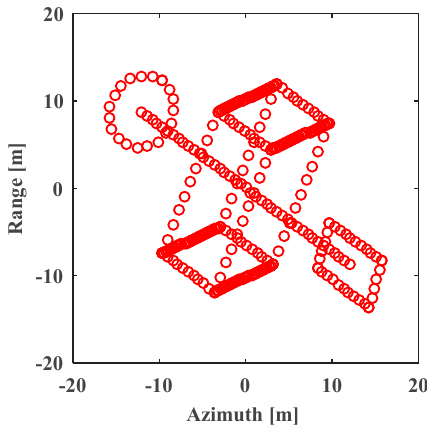
Figure 5. The ideal point scatterer model.